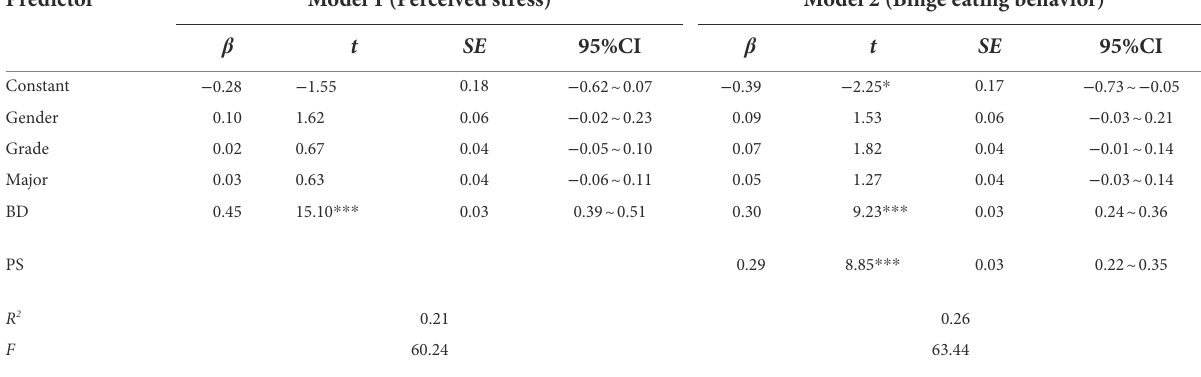
TABLE 2 Testing the mediation effect of perceived stress on binge eating behavior.